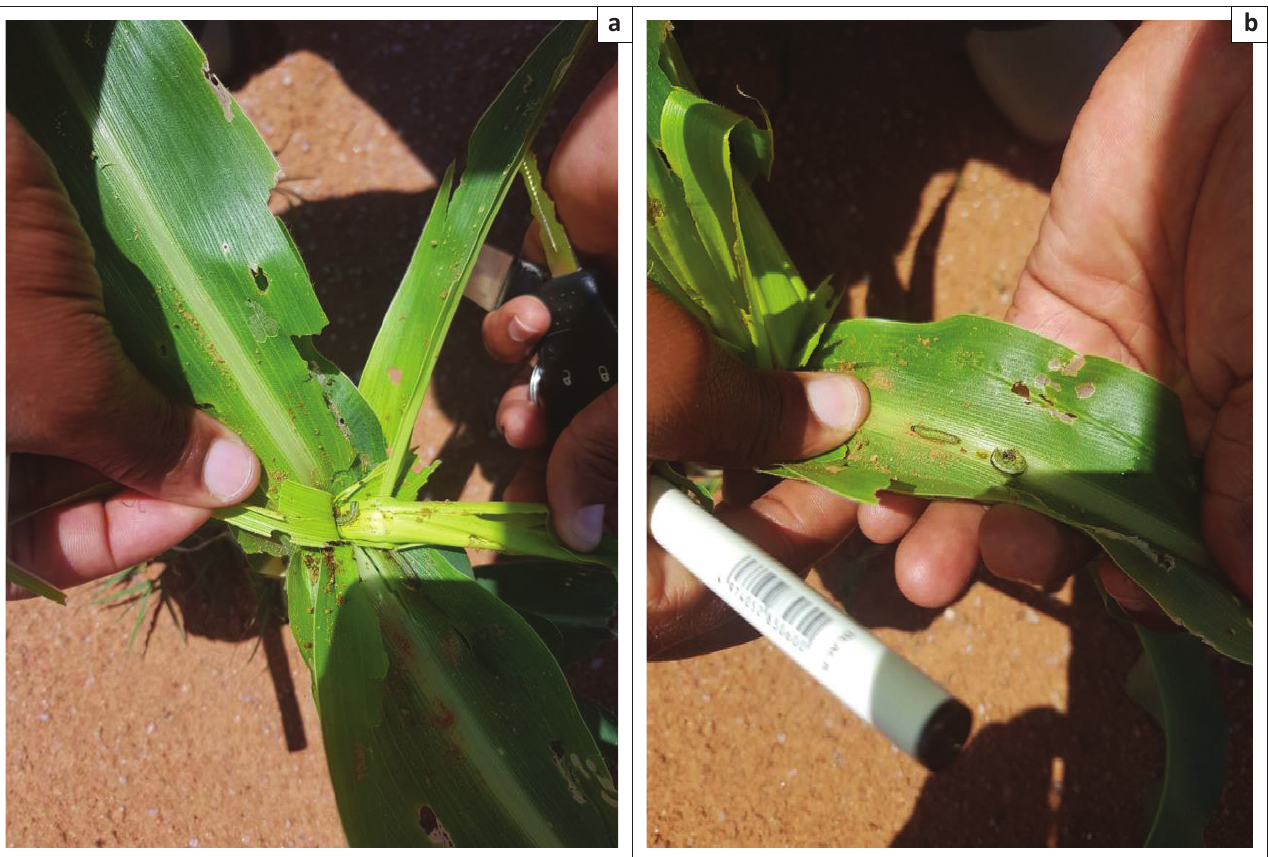
FIGURE 3: Fall armyworm causing damage on maize plant at Maltapa Dryland Farm.